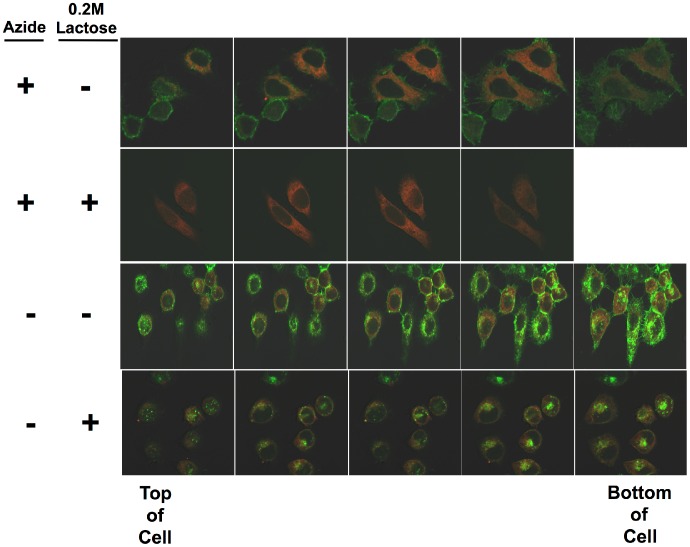
Internalization of fluorescent ricin.HeLa cells stably transfected with pDsRed-ER were plated on glass coverslips and incubated in tissue culture. One day later, half of the slides were washed with cold PBS, 1% BSA, 0.01% sodium azide and incubated in the same, on ice. The remaining slides were left under physiological conditions. Thirty min later, Alexa 488-conjugated ricin was added to each set of slides and the slides were incubated an additional 45 min under the same conditions as previously. Following this, cells were washed 3X with ice cold PBS/BSA/Azide. Cells were then incubated in either PBS or PBS/0.2M lactose for 5 min with orbital shaking. The solution was removed, fresh PBS or PBS/lactose added, and the process repeated three times. The cells were fixed in 2% paraformaldehyde. Cells were viewed with a 62X oil-immersion objective. Each panel shows a Z stack, each plane separated by 0.8 µm. The plane closest to the slide (bottom of the cell) is to the right. Ricin is green, ER red. There is no nuclear stain.